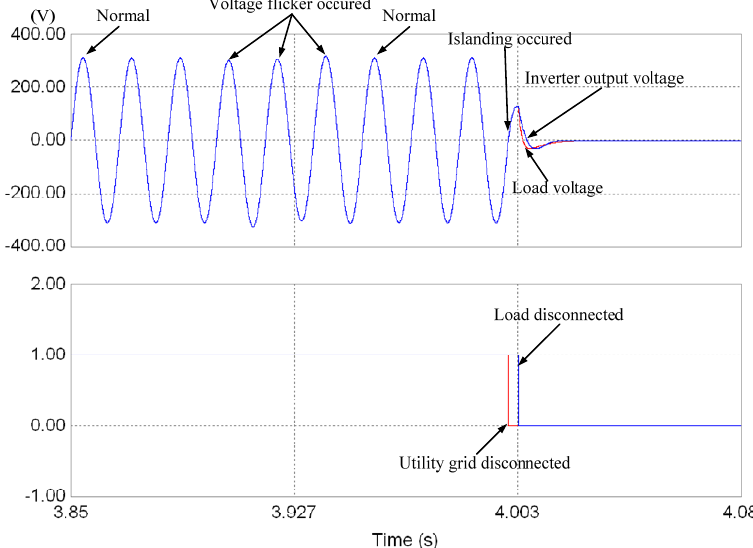
Figure 9. Simulation diagram of islanding detection influenced by voltage